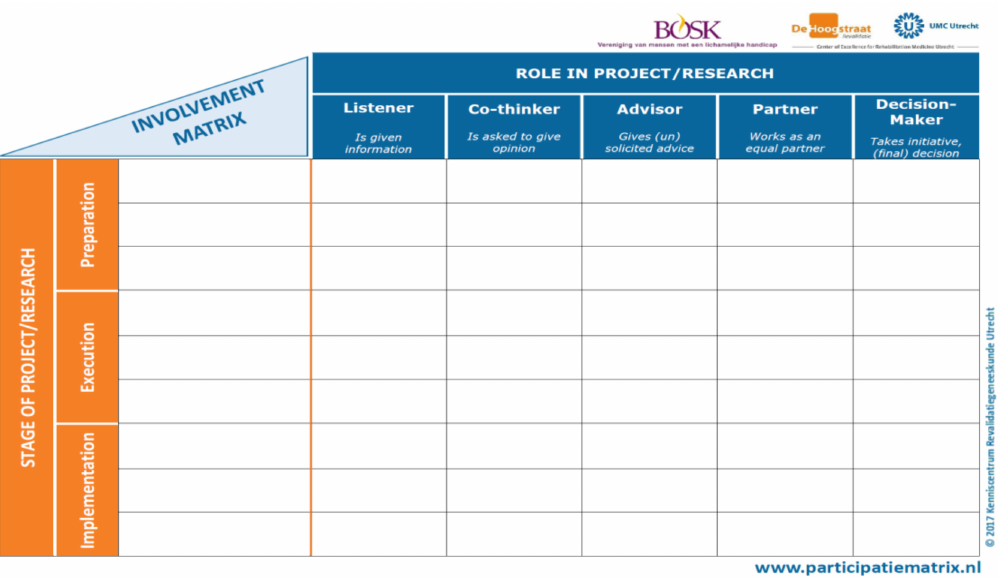
Figure 1. Involvement Matrix; Accessed on 1 March 2019, www.kcrutrecht.nl/involvement-matrix. © Center of Excellence for Rehabilitation Medicine Utrecht, used with permission.